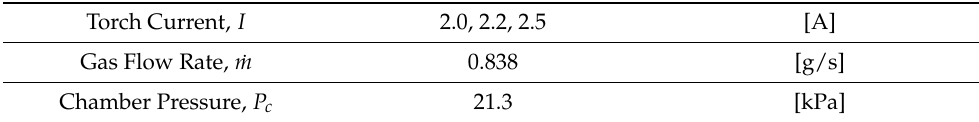
Table 1. Experimental conditions in ICP Torch Facility